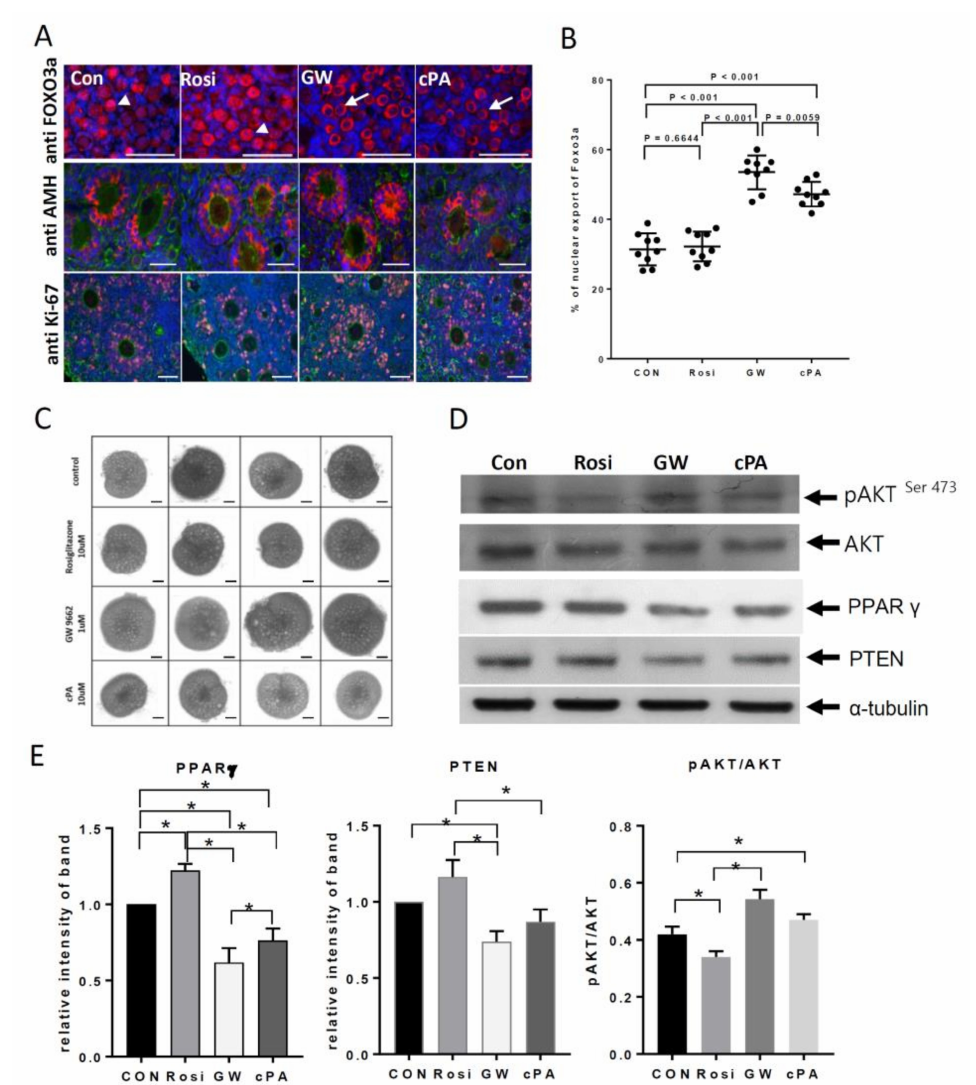
Figure 3. Primordial follicle activation with PPAR γ modulation. ( A ) Nuclear exclusion of forkhead box O3a (FOXO3a) (red) in oocytes of primordial follicles 6 h after treatment with PPAR γ modulators. Arrow heads point to FOXO3a located in the nuclei, whereas arrows point to FOXO3a located in the cytoplasm. Anti-Mullerian hormone (AMH) and Ki-67 staining are also shown in red, as indicated. Counterstaining was performed using anti-actin antibodies (green) and nucleus with DAPI (blue). Scale bar = 10 µ m. ( B ) Percentages of primordial follicles with nuclear export of FOXO3a. ( C ) In vitro culture for 12 days of 5-day-old ovaries after 48 h treatment of PPAR γ modulators. Scale bar = 100 µ m. ( D ) Western blot analysis of ovaries after a 3-day treatment with PPAR γ modulators. ( E ) Quantitation of results shown in ( D ). * indicates significant di ff erences between groups, p <